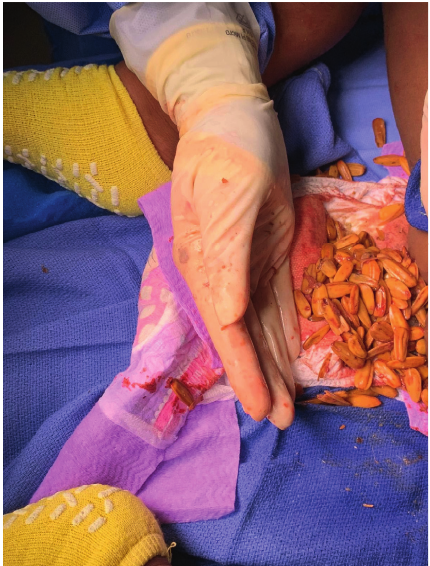
Figure 3: Sunflower seeds removed by manual disimpaction from the rectum and rectosigmoid colon. There is minimal fecal material with some specks of blood secondary to trauma. Photo was ob- tained with signed and informed